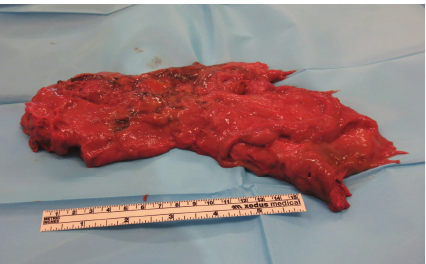
Figure 1: Large, malodourous mass removed manually under